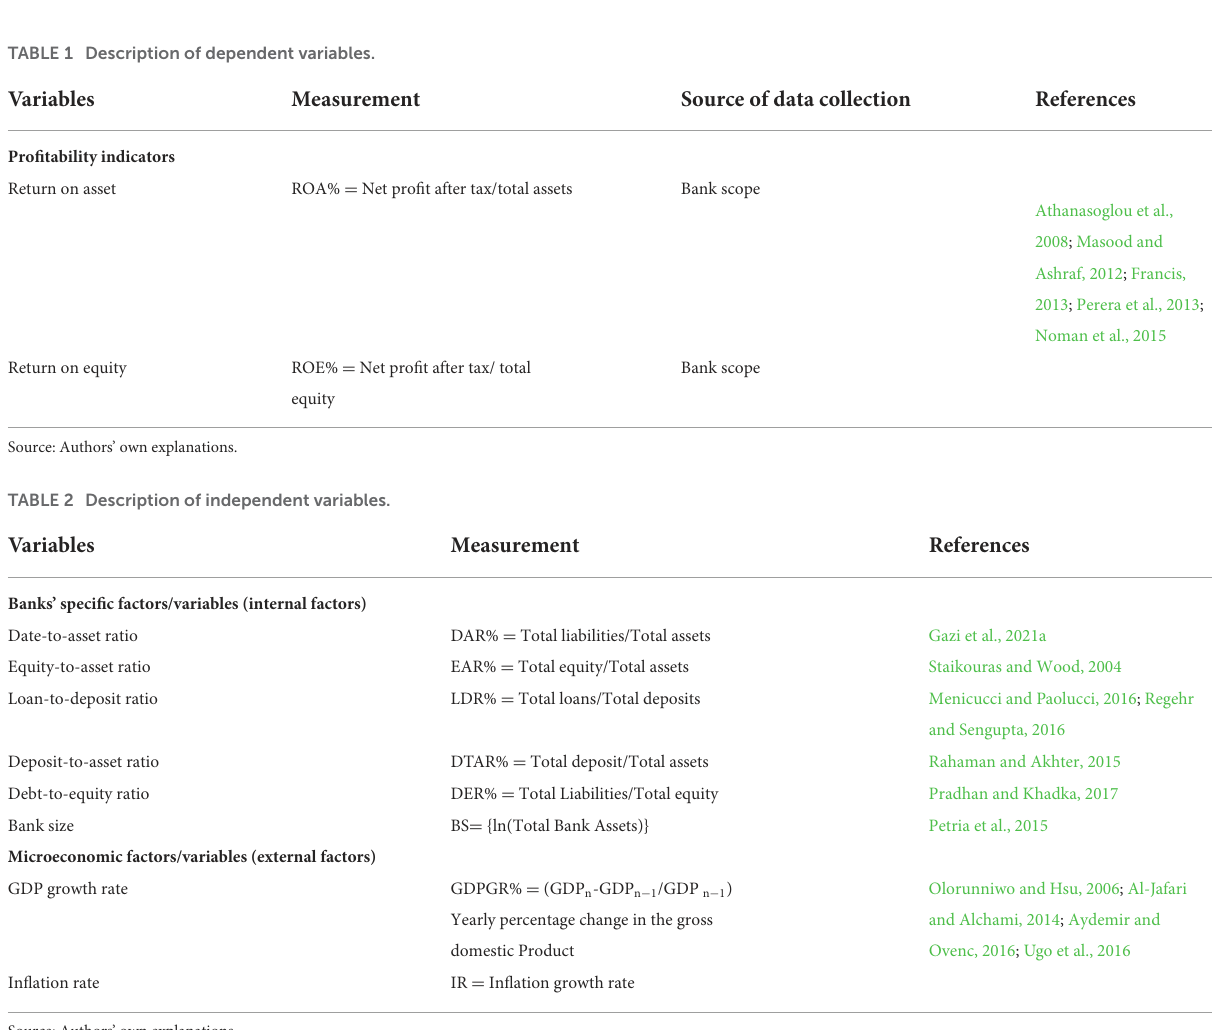
TABLE 1 Description of dependent variables.